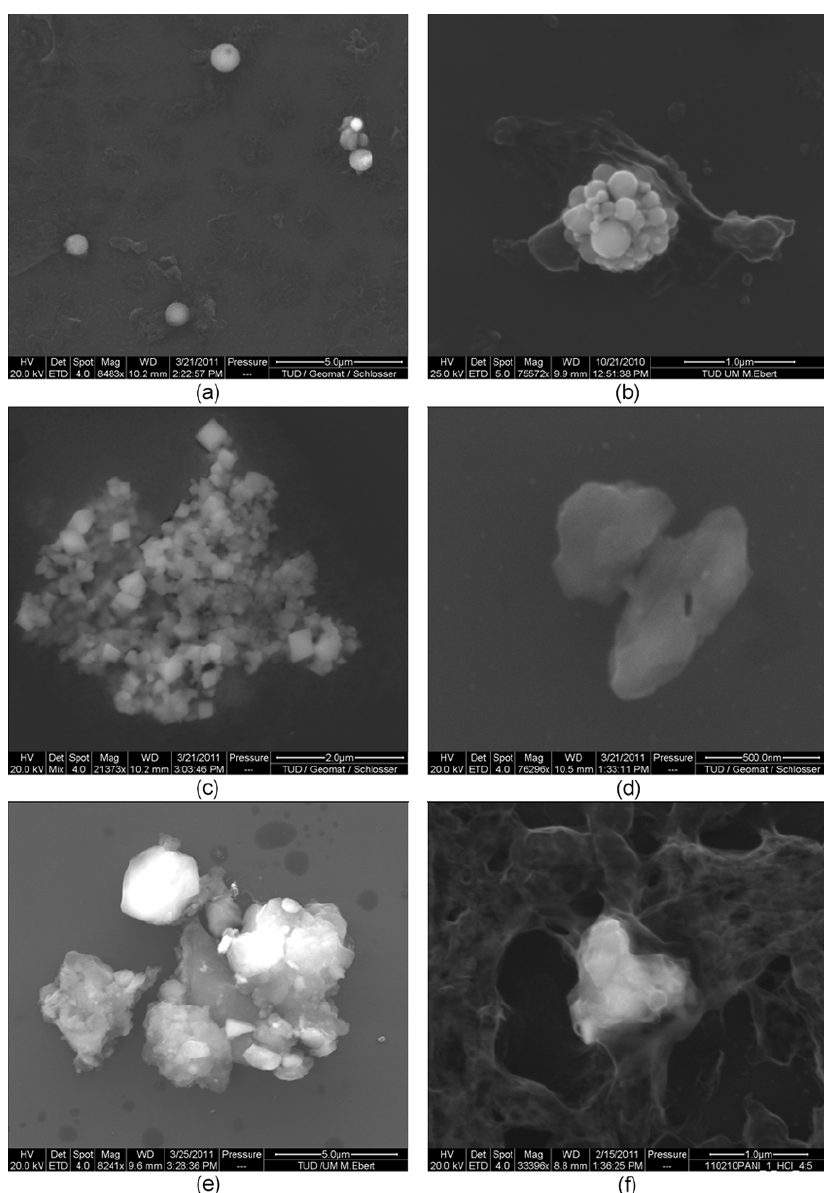
Figure 3. Secondary electron images of refractory particles in the coarse fraction: (a) silicatic spheres; (b) Fe-rich particle; (c) complex metallic mixture (Al / Cr / Mn / Fe); (d) Ca-rich particle; (e) carbon / silicate mixture; (f) silicate